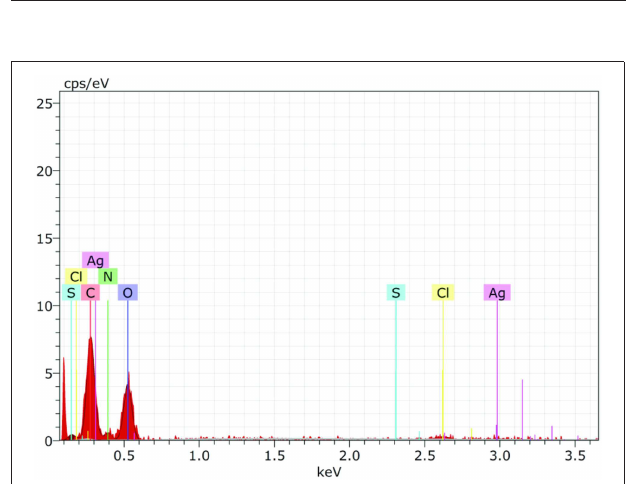
FIGURE 7 | The Energy Dispersive Spectroscopy (EDS) confirmed the presence of elemental silver and AiiA (Protein) inside the reaction mixture. The presence of wide peak of silver around 0.3 keV strongly indicated toward the reduction of silver nitrate to silver nanoparticles